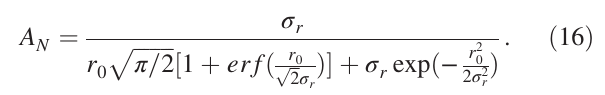
9. Various beam transverse distribution f ð r Þ with beam ¼ 2 radius R e